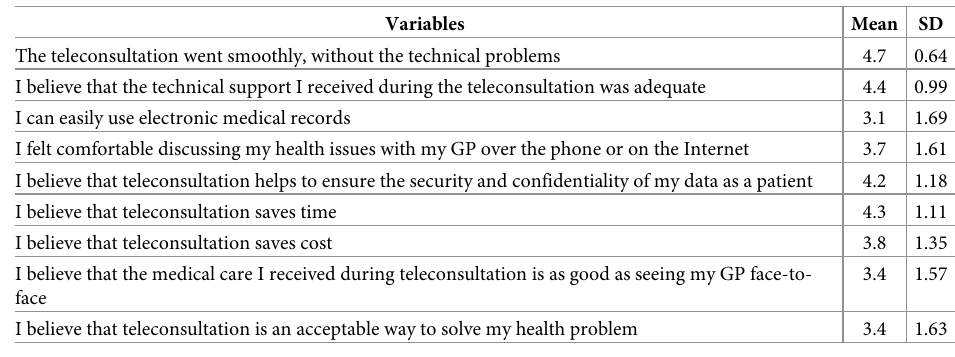
Table 6. Dimensions and variables used to measure the system